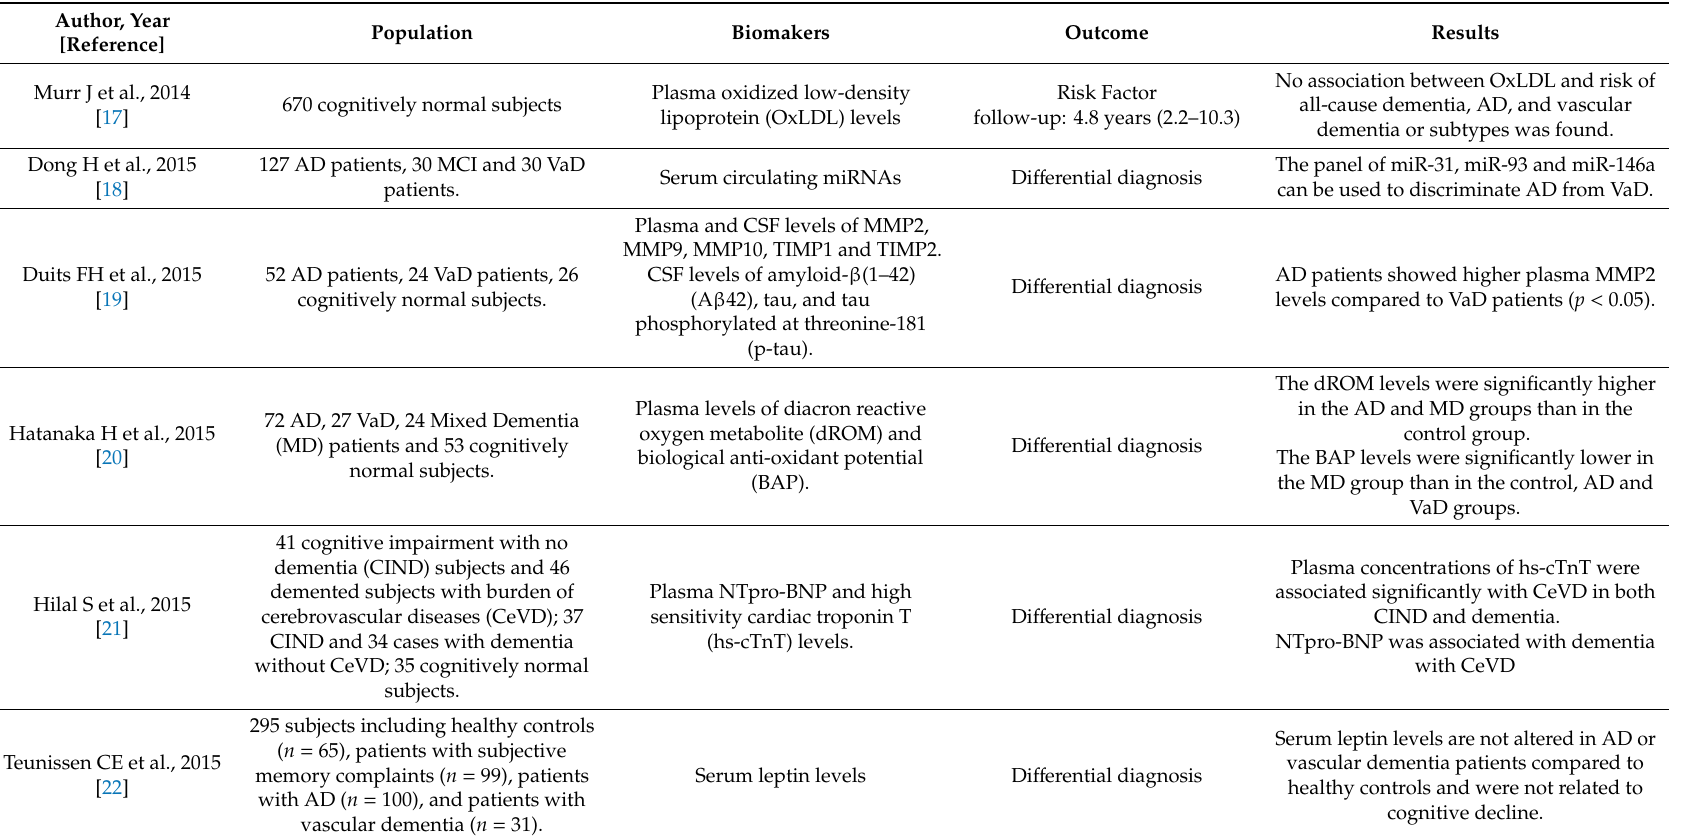
Table 1. Blood biomarkers and